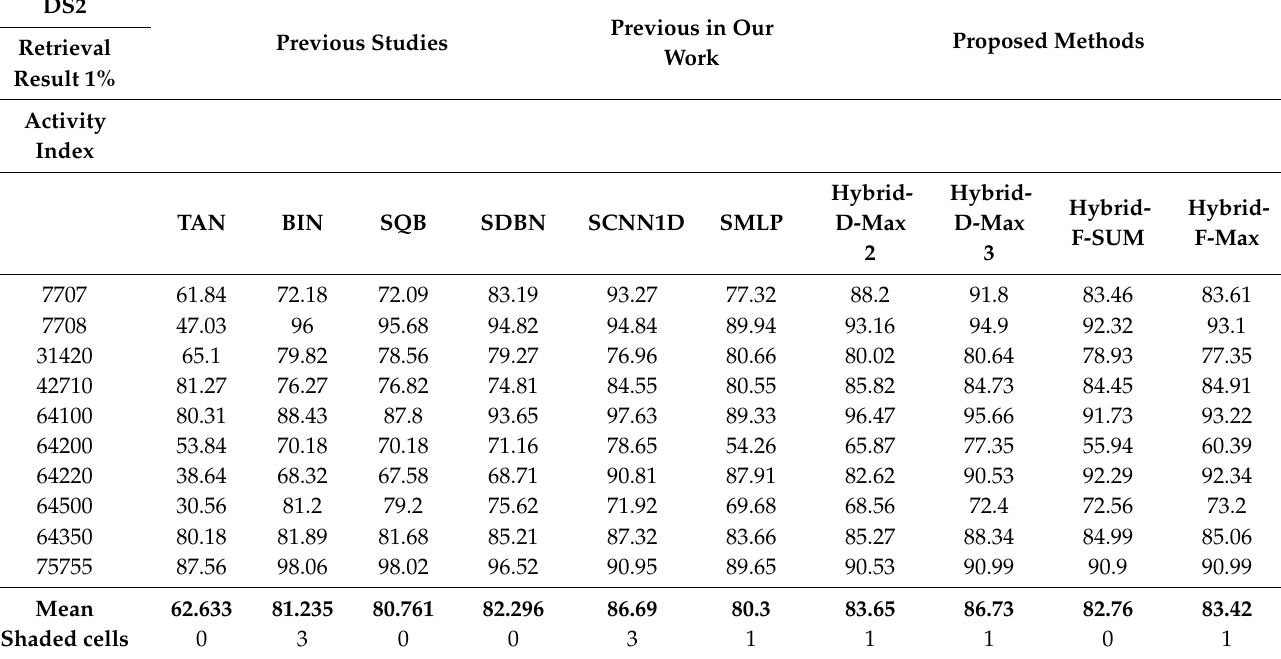
Table 7. Top 1% retrieval recall for MDDR-DS2 (structurally homogeneous) dataset for descriptor (ECFC